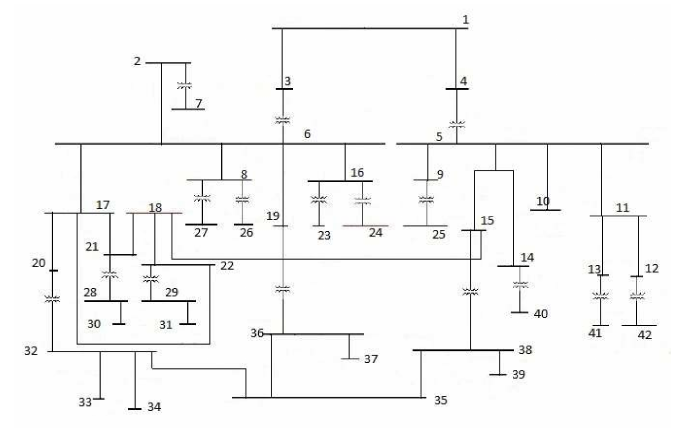
Figure 4. Single line diagram of the network